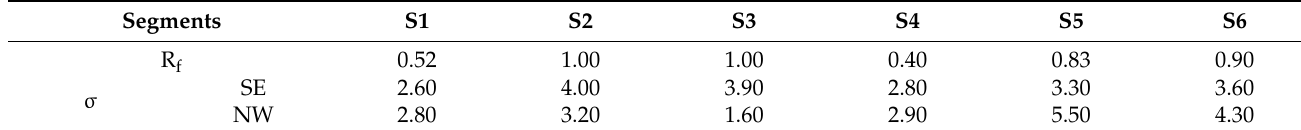
Table 18. The data of the wind speed dispersion and skyline rhythm index.